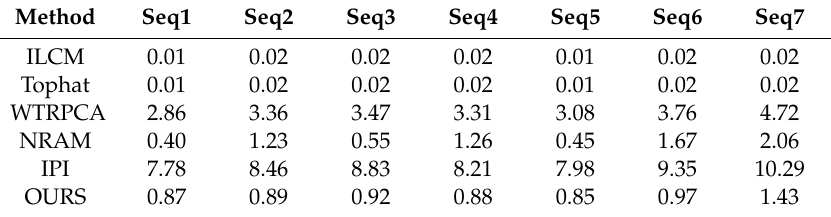
Table 6 . Calculation times of representative scenes. (Unit: second)